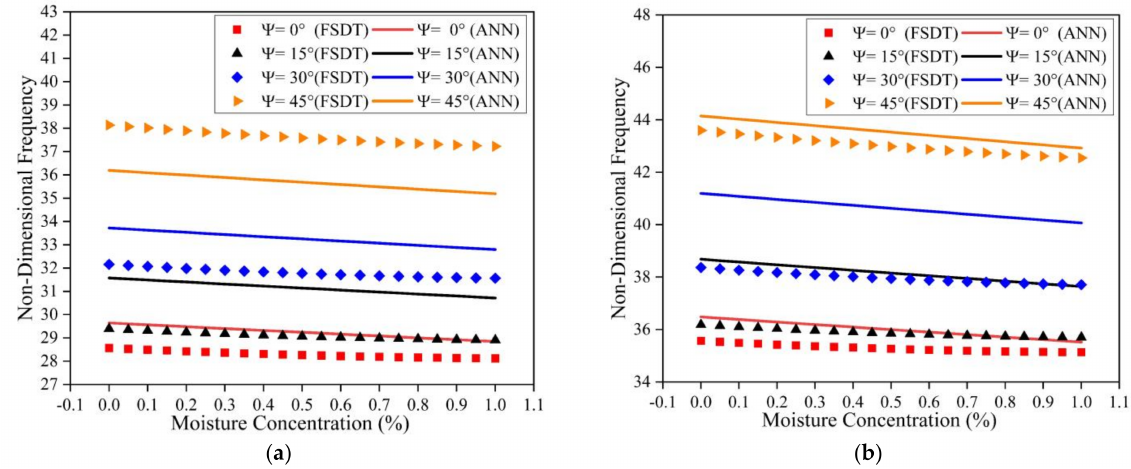
Figure 9. Influence of moisture environment on the fundamental frequency of the LCS plate under ( a ) SSSS and ( b ) CCCC boundary